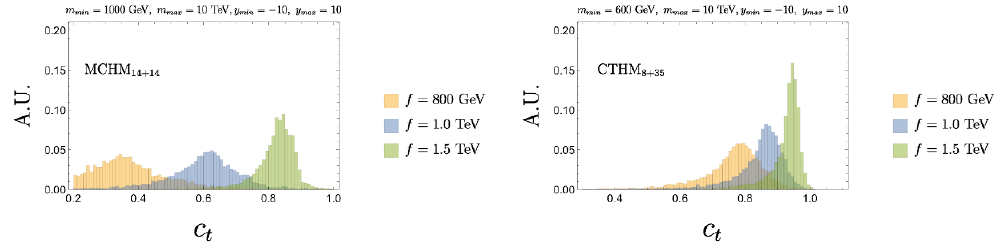
Figure 8 . The distribution of c t in the models with low dimensional representations. Di(cid:11)erent colors denote di(cid:11)erent values of (cid:24) , the width of each bin is chosen as 0 : 01, and A.U. denotes arbitrary